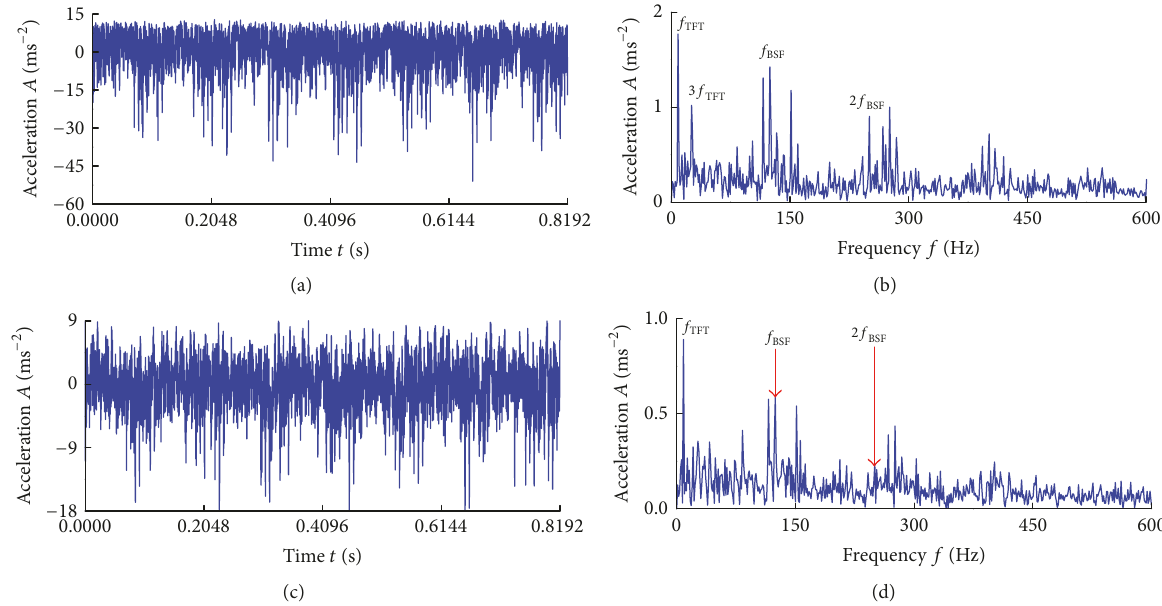
Figure 21: The intrinsic envelope extracted from the envelope space of IMFs: (a) corresponding to dimensionality 1, (b) the Fourier spectra of (a), (c) corresponding to dimensionality 2, and (d) the Fourier spectra of